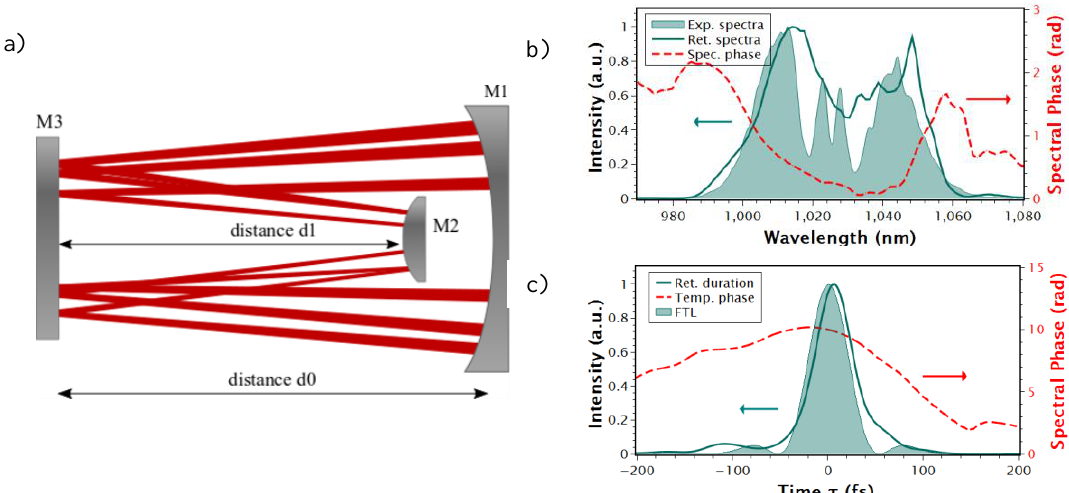
Fig. 1 a) Folding geometry for a convex-concave nonlinear multipass cell. b) Measured (shaded area) and FROG-retrieved (solid line) output spectrum and spectral phase (dashed line) for the Concave – Convex configuration at input energy of 15 μJ. The FROG error is 7×10 −3 on a 256 × 256 grid. c) FROG-retrieved temporal profile (solid line), temporal phase profile (dashed line) and FTL reference (shaded area). The measured duration of 53 fs with FTL of 49